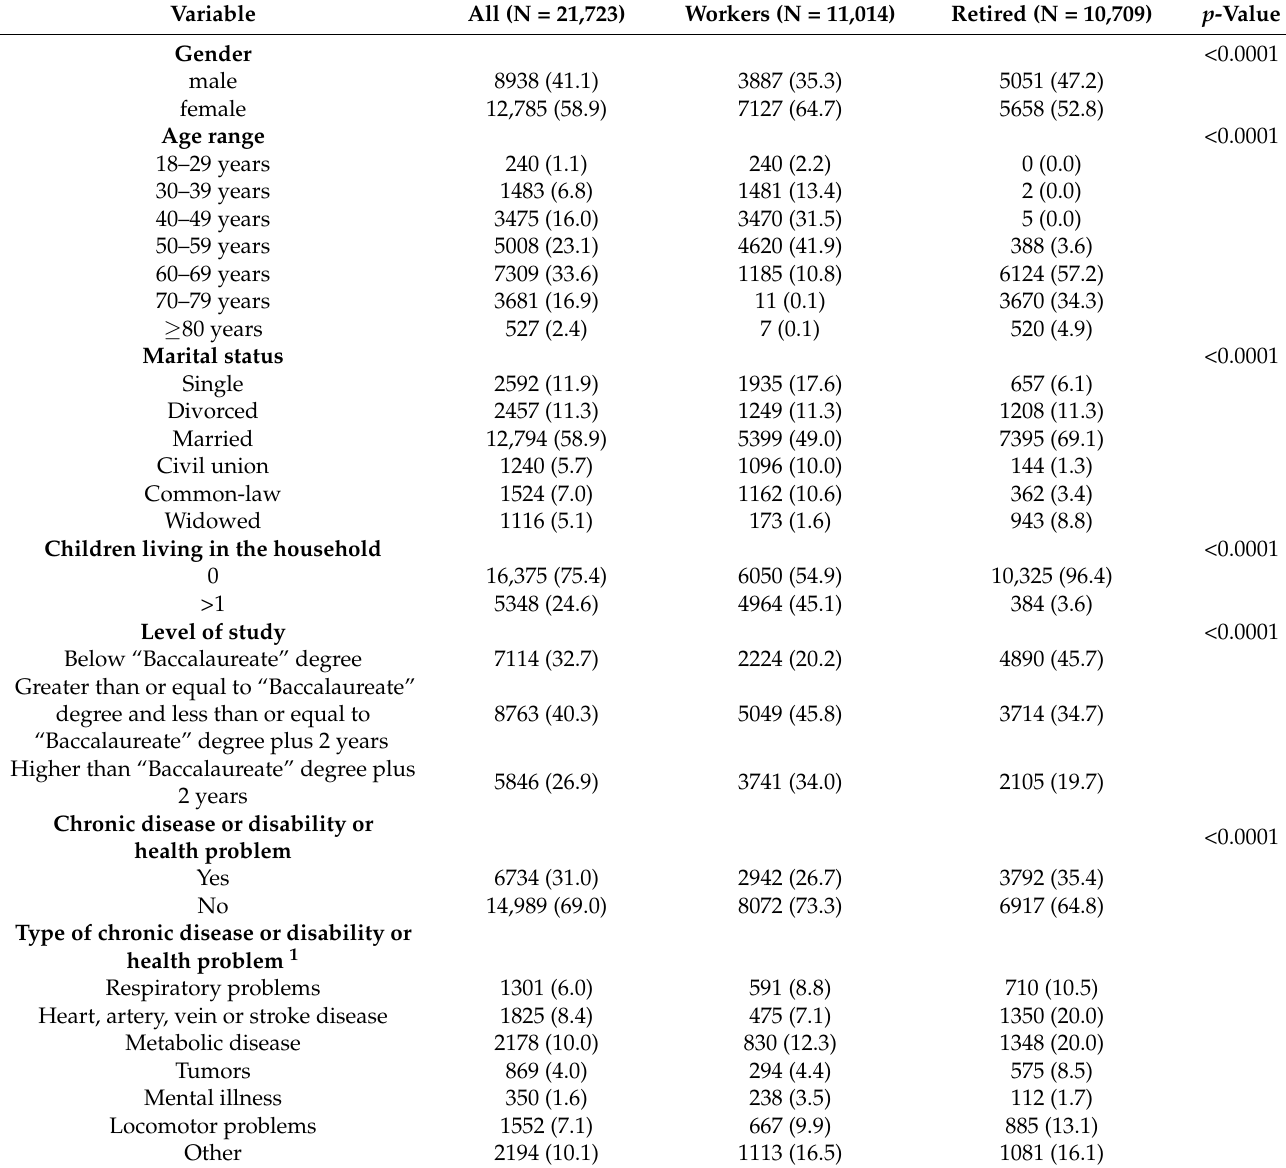
Table 1. Socio-demographic characteristics and chronic illness categories of the respondents according to occupational status. The results are expressed as n (%). n: number of respondents, %: